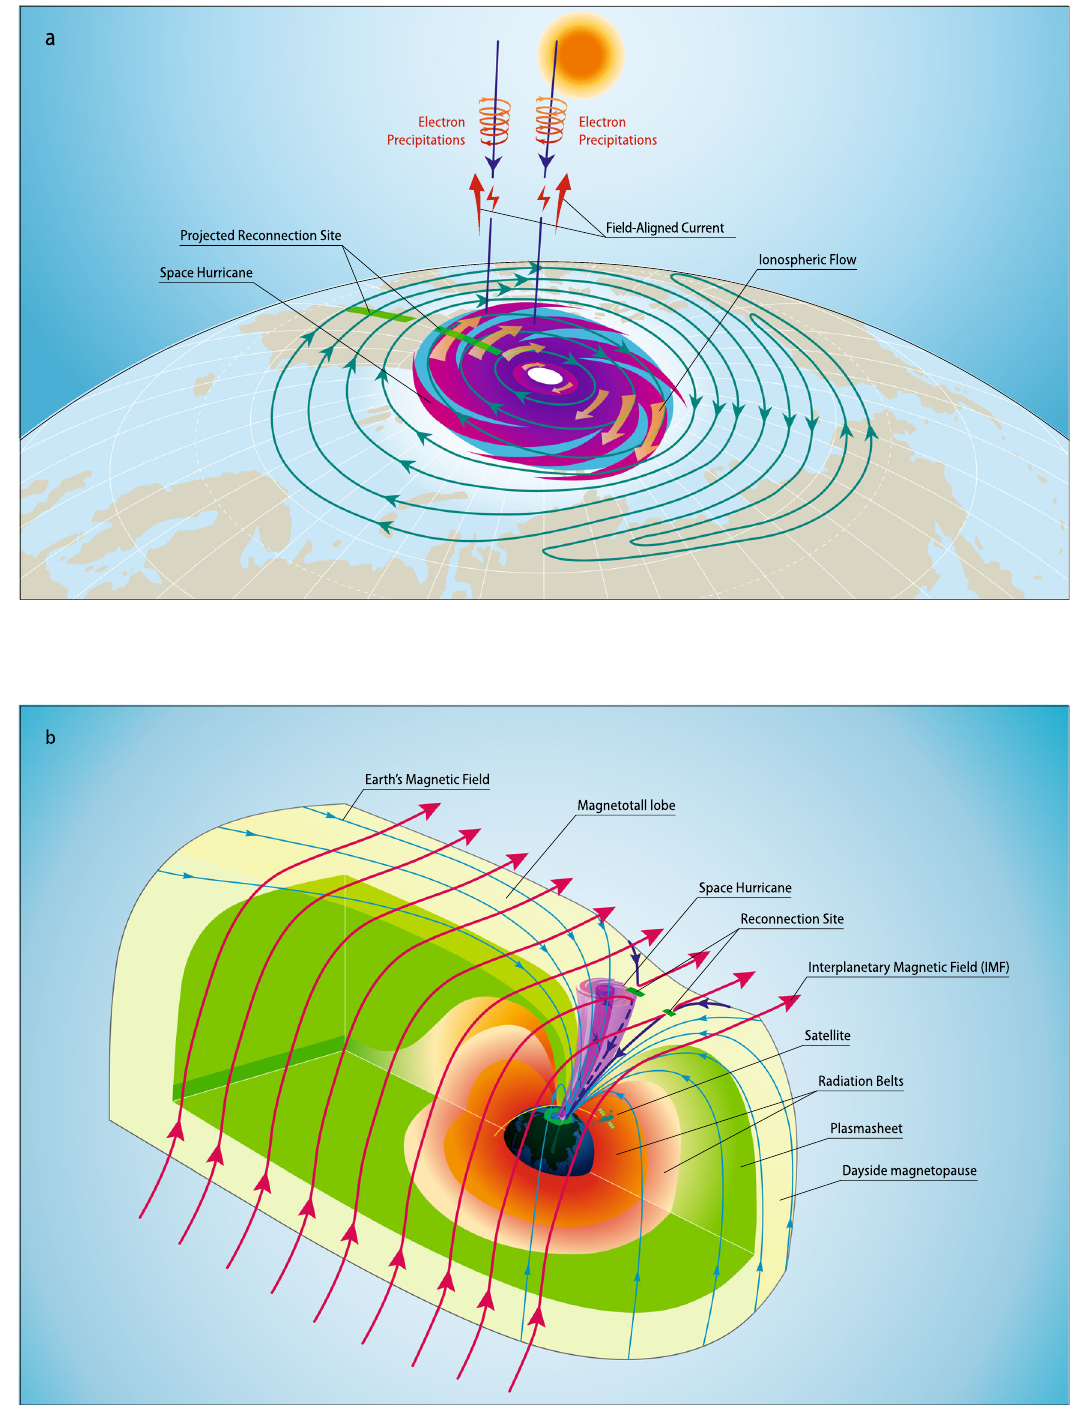
Fig. 5 Schematic of the space hurricane and its formation mechanism during an extremely quiet geomagnetic condition with northward IMF and a dominant By component. a Schematic of a space hurricane in the northern polar ionosphere. The magenta cyclone-shape auroral spot with brown thick arrows of circular ionospheric fl ows represents the space hurricane with a light green background showing the downward FACs. Convection streamlines are in blue with green thick crossed bars that shows the projected magnetic reconnection sites at the dayside magnetopause around equatorward and tailward (lobe) boundary of the cusp 29,30 . The vertical dark blue lines represent the Earth ’ s magnetic fi eld lines with electron precipitations and FACs. The sun is on the top representing the polar ionosphere is under sunlight conditions during the interval of interest. b Schematic of the 3-D magnetosphere when a space hurricane happened. Different color shadings represent different regions of the magnetosphere. The shaded magenta funnel shows the space hurricane in the magnetosphere. Red, black and blue curves with arrows are the interplanetary magnetic fi eld lines, Earth ’ s magnetic fi eld lines, and newly reconnected Earth ’ s magnetic fi eld lines. The green thick bars represent the reconnection sites. The yellow curve with a satellite icon shows the satellite orbit. In this case, magnetopause reconnection can take place at the dayside magnetopause around equatorward and tailward (lobe) boundary of the cusp 29,30 . Due to a steady high-latitude lobe reconnection, a funnel (space hurricane) formed just poleward of the cusp region ( b ), and a large ionospheric convection lobe-cell with strong circular horizontal plasma fl ow inside the normal afternoon convection cell ( a